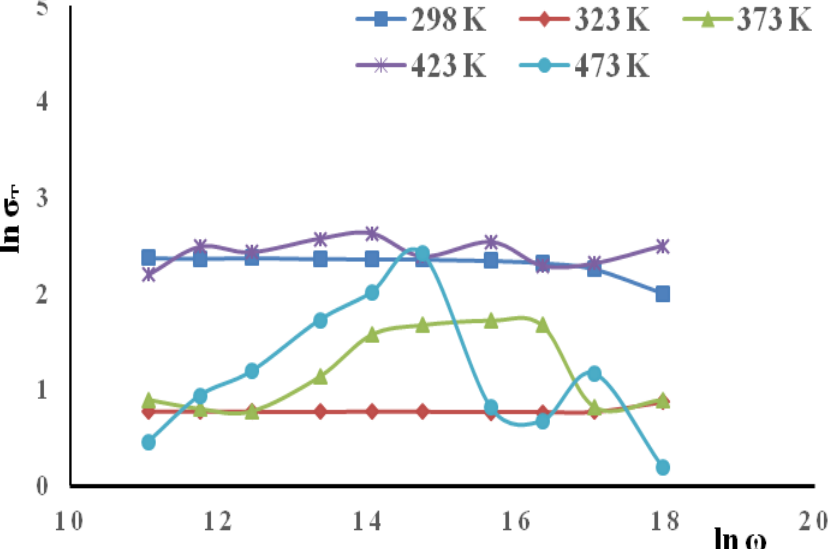
Fig. 2: The variation of ln σ